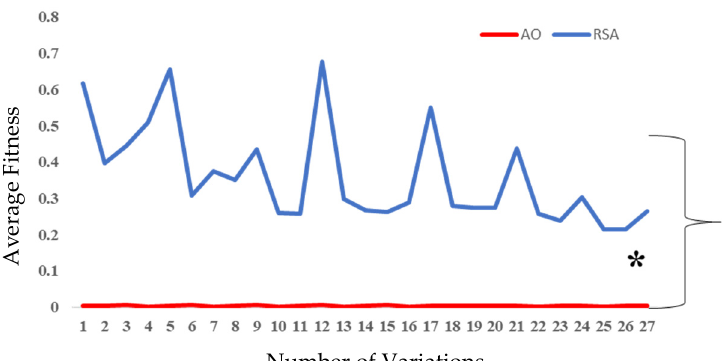
Figure 10. Mann-Whitney U test between AO and RSA where * p < 0.01.